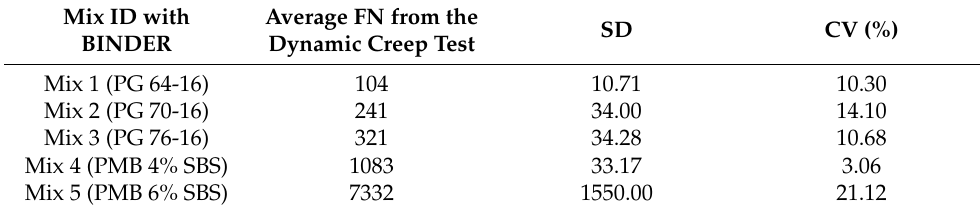
Table 7. FN results of the five mixes from Dynamic Creep